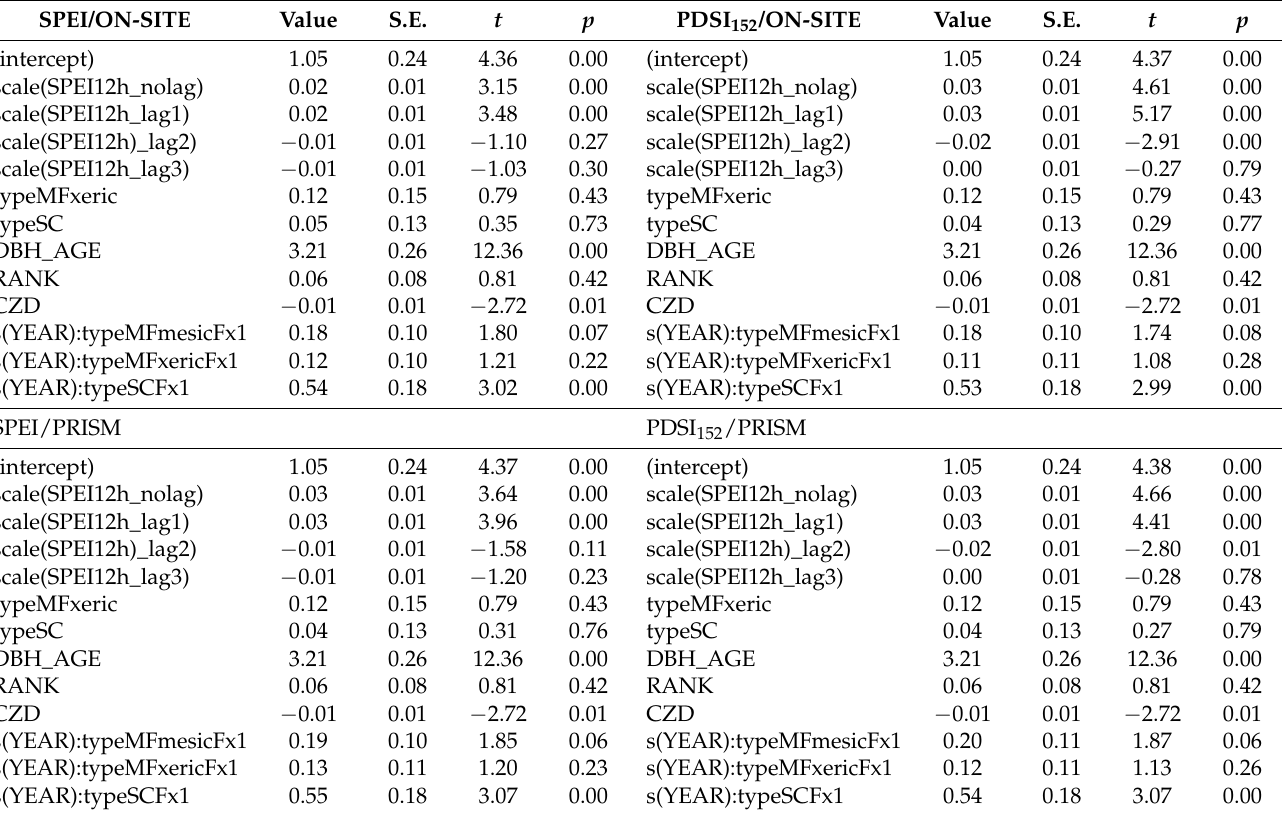
Table 6. Fitted coefficients for the full models predicting BAI for on-site and PRISM parameterizations of SPEI and PDSI 152 at MFm (primary site), MFx, and SC